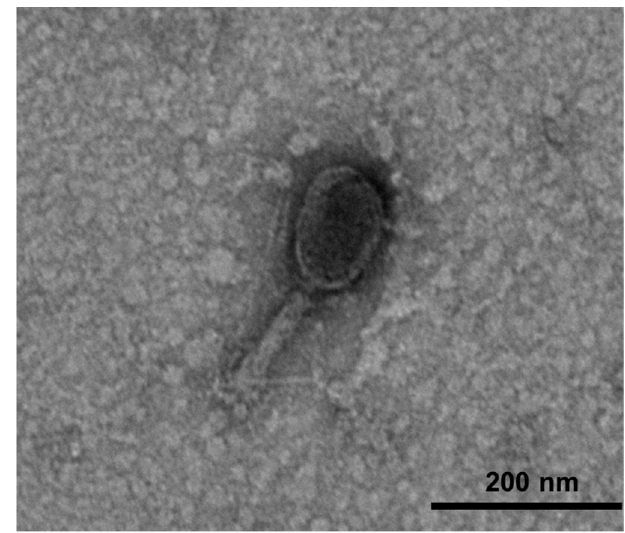
Figure 1. TEM images of KFS-EC3 at a magnification of × 25.0 k.